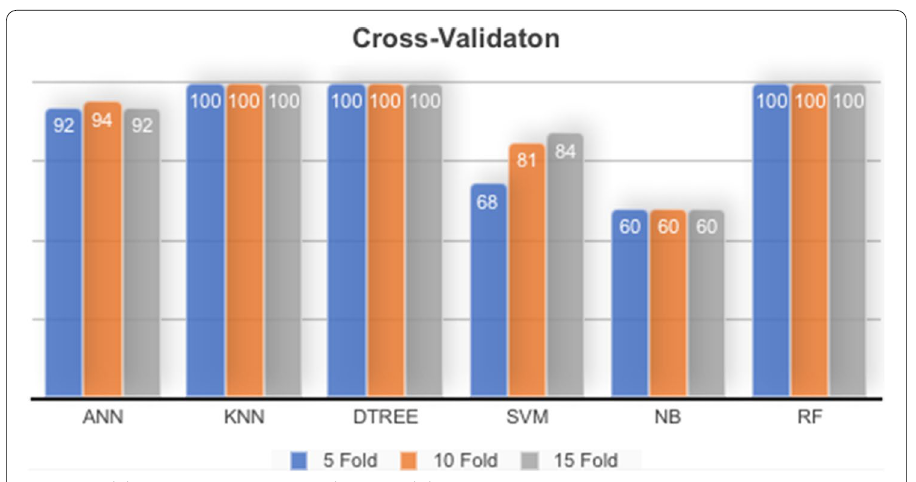
Fig. 5 Model accuracy comparison with